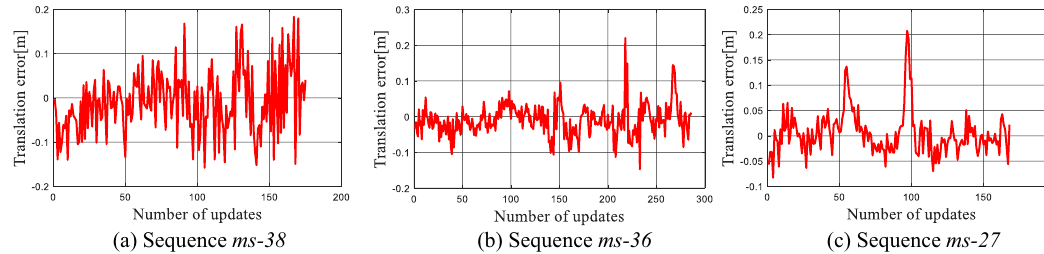
Figure 7. The translational errors e trans , t in the localization tests on MIT Stata